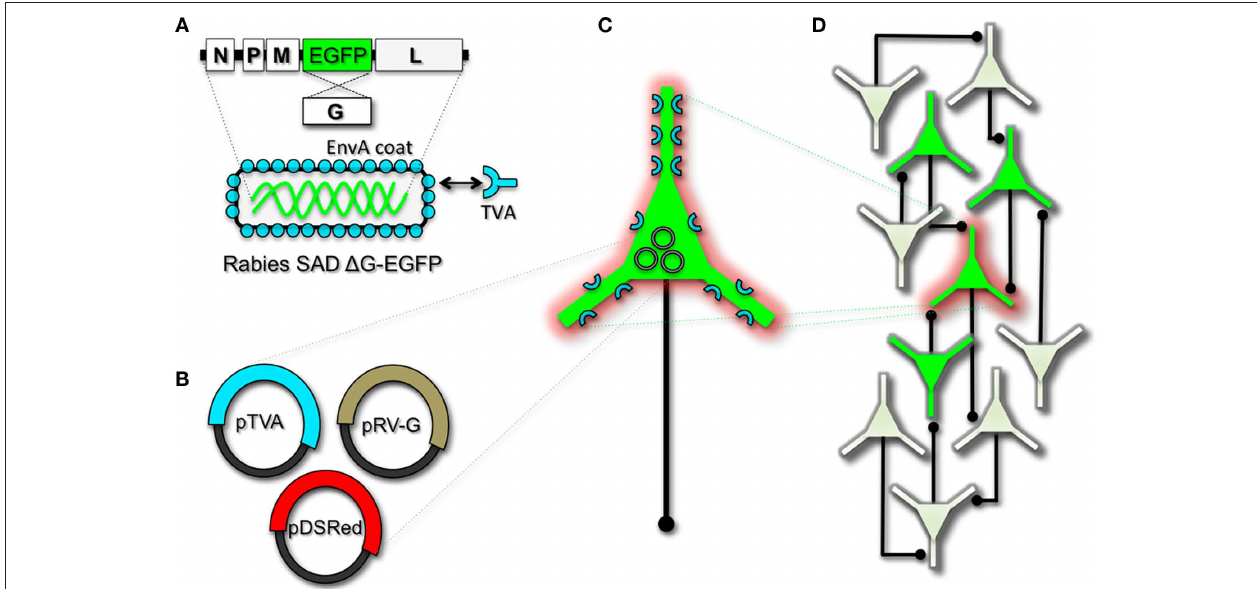
Figure 2 | engineering and pseudotyping rabies virus (rV) for transneuronal tracing. (A) RV can be genetically engineered to express EGFP by replacing the genomic sequence encoding the G coat protein. The genetically modified G-deletion mutant RV must be propagated in vitro to supply a coat protein. The particle can thus be pseudotyped by providing a foreign coat protein such as EnvA, which originates from the avian leukosis virus and binds specifically to it its cognate receptor TVA. EnvA pseudotyped RV can be used to selectively infect neurons that have been genetically targeted for TVA expression. By including additional constructs that encode the wildtype